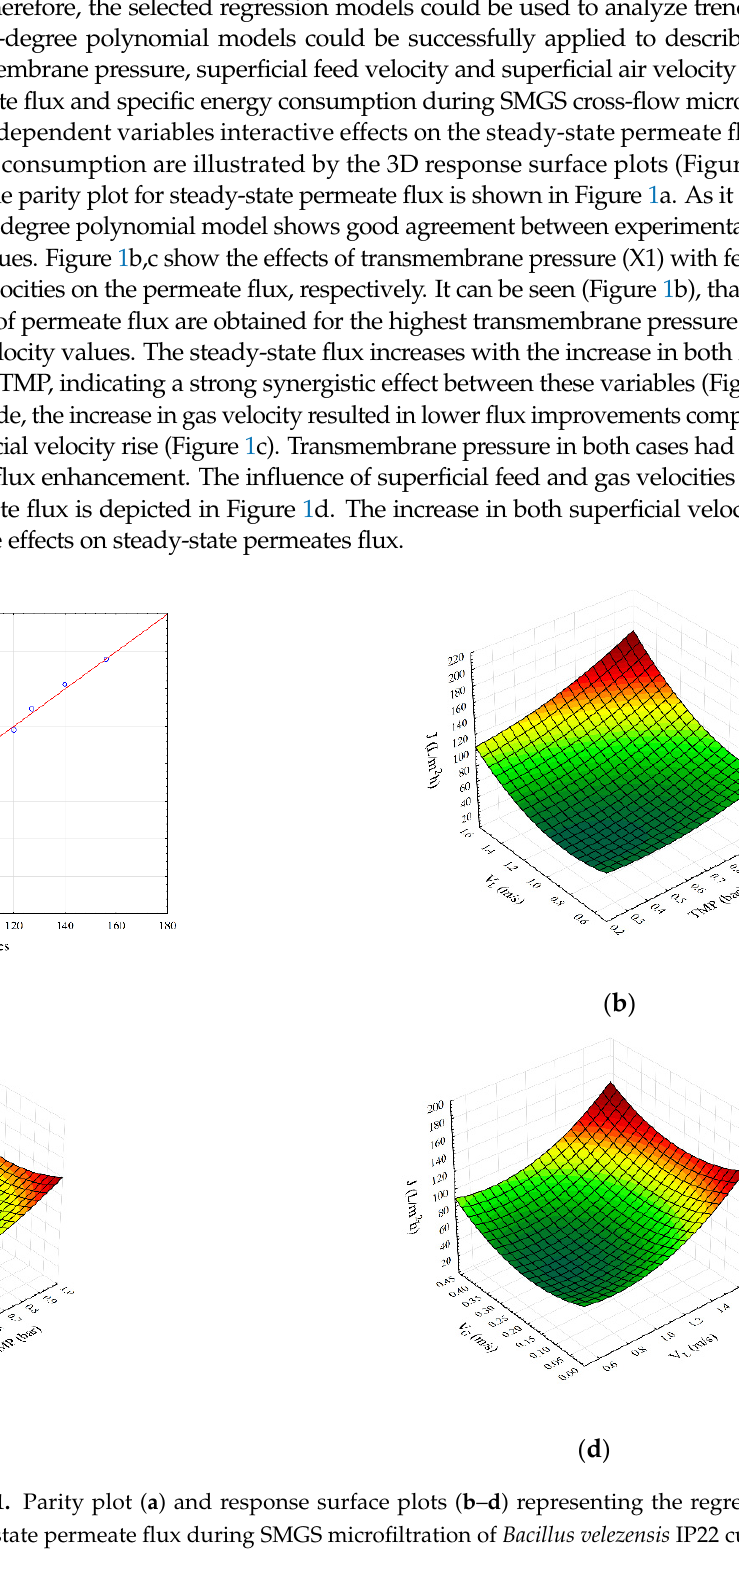
2b) that maximum values of specific energy consumption are obtained for the highest su- perficial feed velocity values and lower transmembrane pressure values. The specific en- ergy consumption increases with the increase in transmembrane pressure at lower super- ficial air velocities. On the other hand, at higher TMP values, specific energy consumption decreases at higher air velocities (Figure 2c). The influence of superficial feed and gas ve- locities on specific energy consumption is represented in Figure 2d. An increase in both superficial velocities results in a decline in specific energy consumption. ( a )